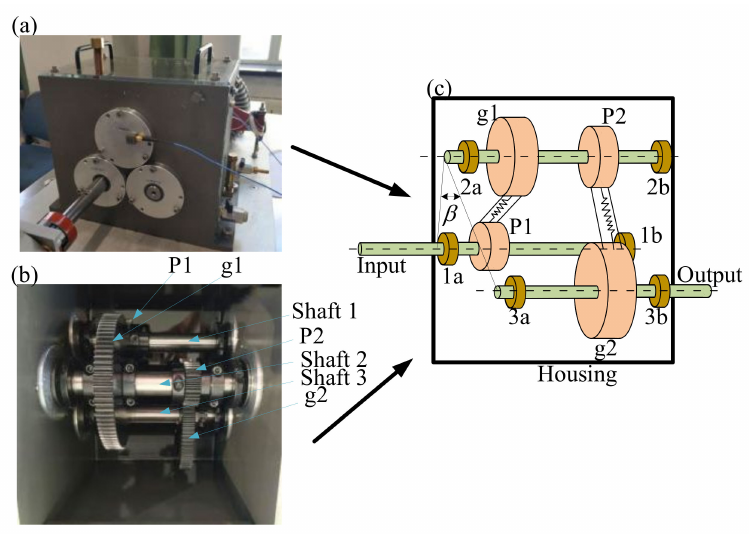
Figure 16. Two-stage gearbox. ( a ) Outside and ( b ) inside of the gearbox from real photos. ( c ) Sketch of the gear